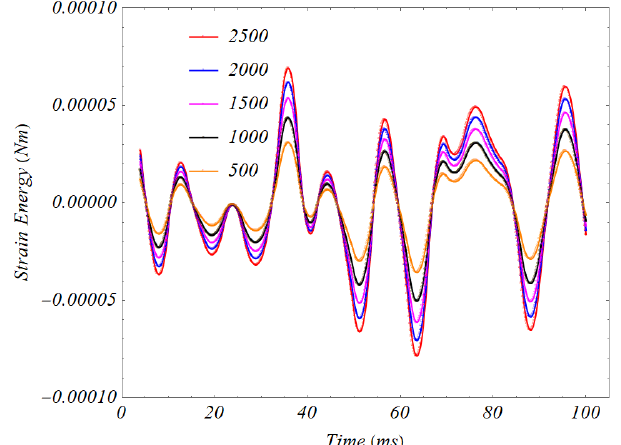
Fig. 14. Strain energy against time for various drop distances with two cellphone casing laminates.